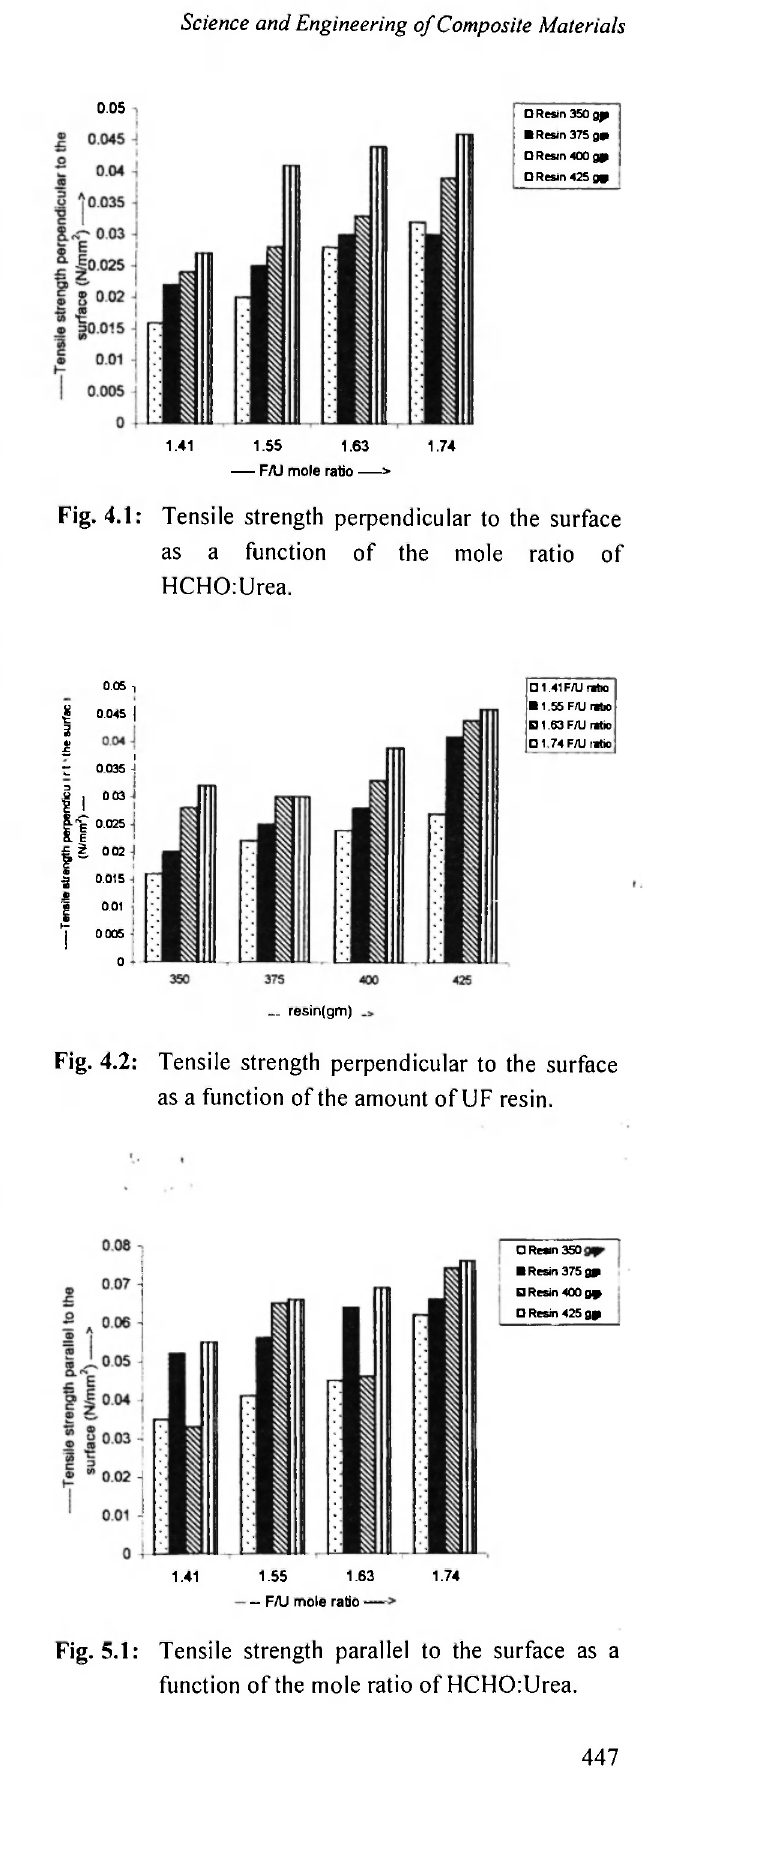
Fig. 5.1: Tensile strength parallel to the surface as a function of the mole ratio of